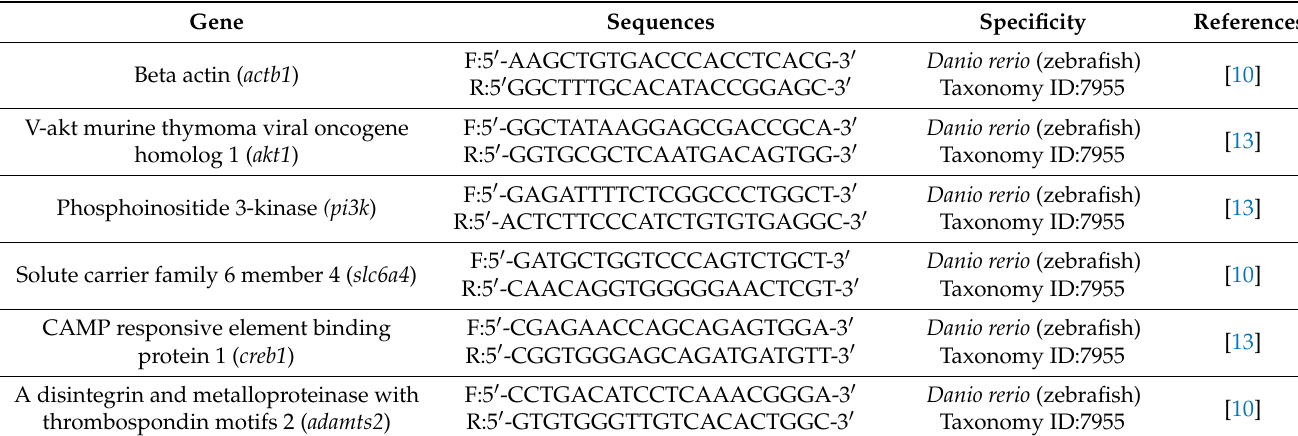
Table A2. List of the primer sequences used for real-time